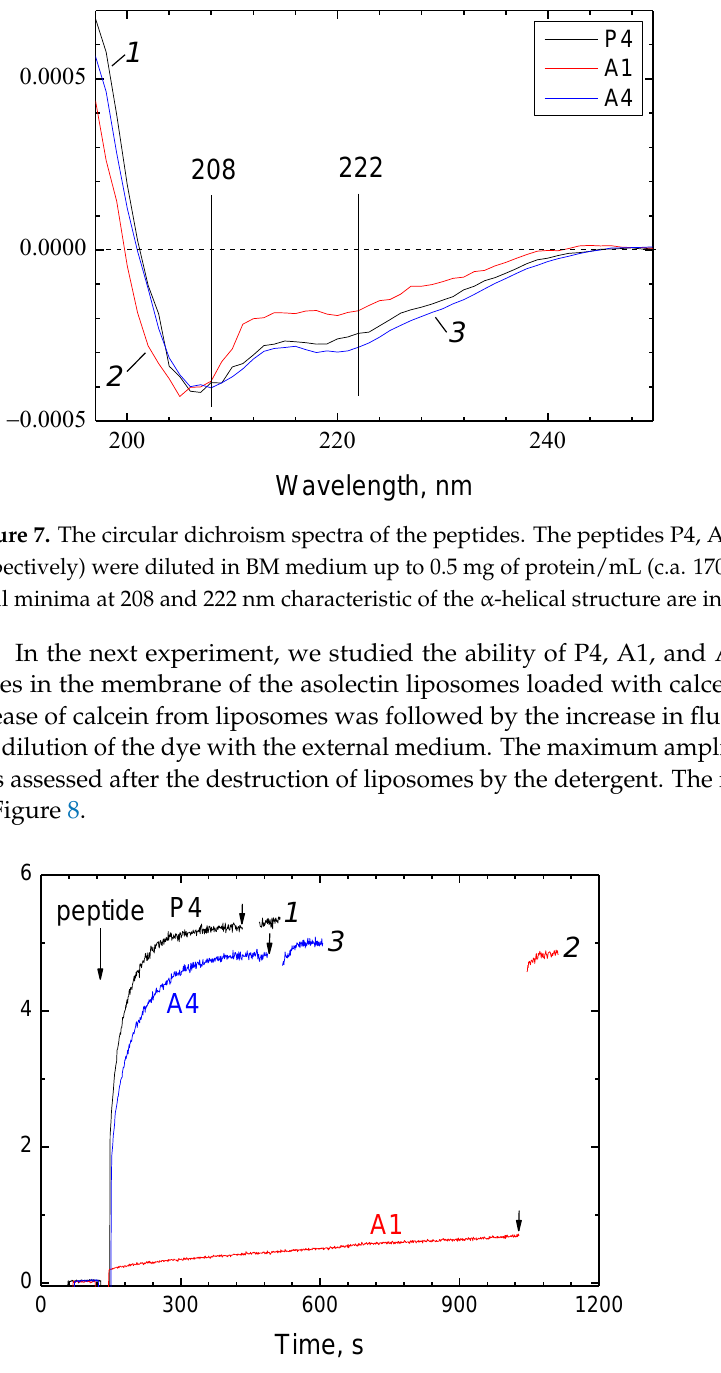
Figure 8. Permeabilization of calcein-loaded liposomes by the peptides. Calcein-loaded asolectin liposomes were diluted in the experimental medium (20 mM MOPS/Tris pH 7.3, 0.2 mM EDTA) to 0.1 mg of lipid/mL. After recording the initial fluorescence trace, the peptide P4 (trace 1), A1 (trace 2) or A4 (trace 3) was injected up to 5 µ M, as indicated. The resulting increase in fluorescence reflects the kinetics of calcein release. The second addition of Triton X-100 (up to 0.1%) is shown by the arrows.